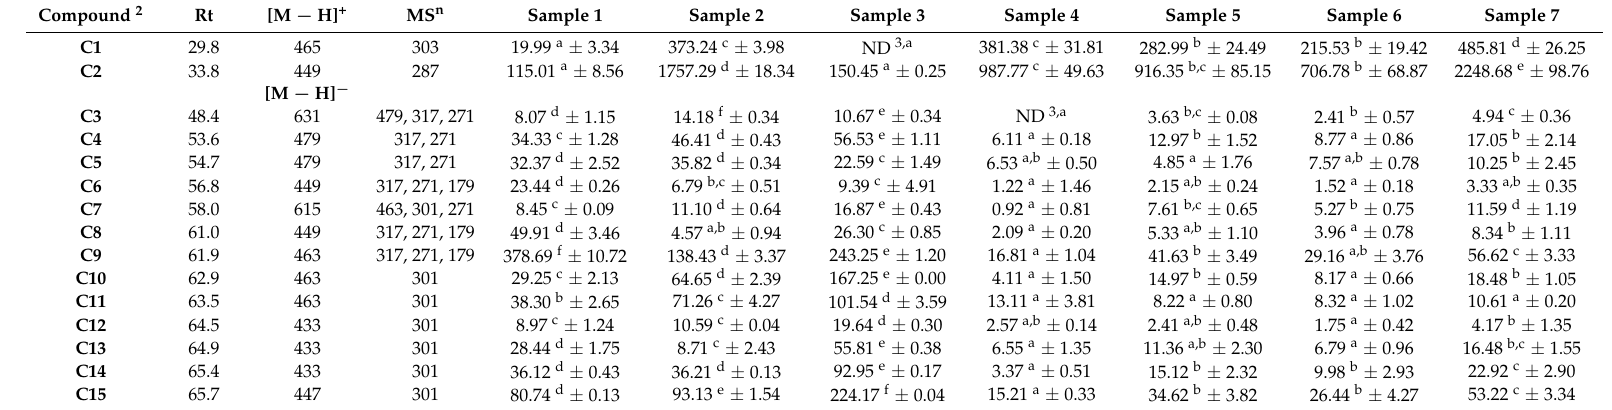
Table 2. Phenolic compounds identified and quantified ( µ mol/100 g dry weight) in different samples 1 .